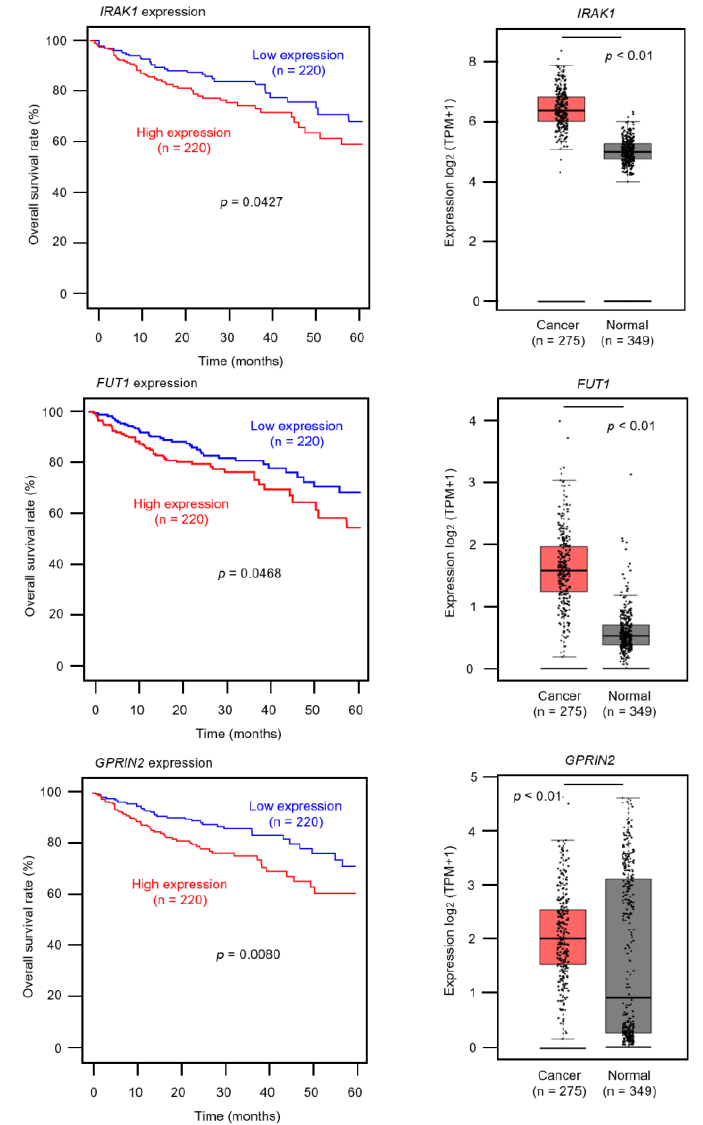
Figure 6. Clinical significance of miR-490-3p target genes ( IRAK1 , FUT1, and GPRIN2 ) in CRC cohort data analysis. Among 38 putative target genes, 3 genes ( IRAK1 , FUT1 and GPRIN2 ) were significantly associated with poor prognosis in patients with colorectal cancer ( p < 0.05). Kaplan–Meier curves for 5-year overall survivals of 3 genes are shown at left side. Patients were divided into high and low groups (relative to median expression) according to miRNA expression. The red line shows the high expression group, and the blue line shows the low expression group. Expression levels of three genes ( IRAK1 , FUT1, and GPRIN2 ) in CRC tissues and normal tissues obtained from TCGA-COAD, based on the GEPIA2 platform, are shown at the right side.